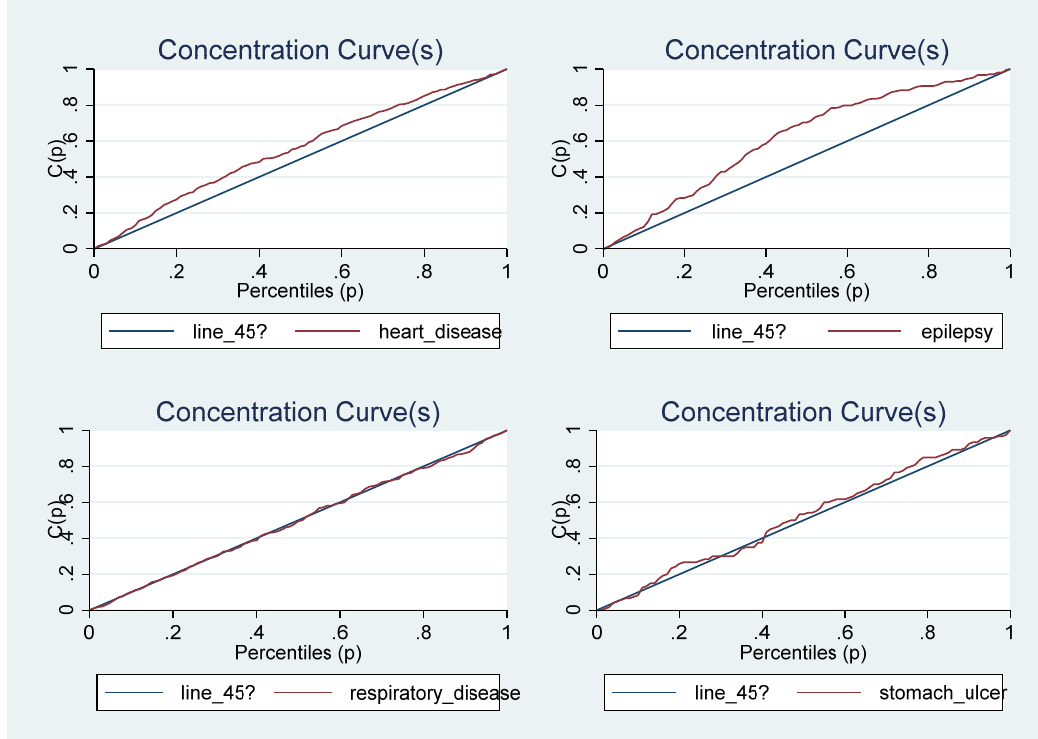
Figure 3. The Concentration Curves for some tobacco/alcohol ‐ related chronic diseases.